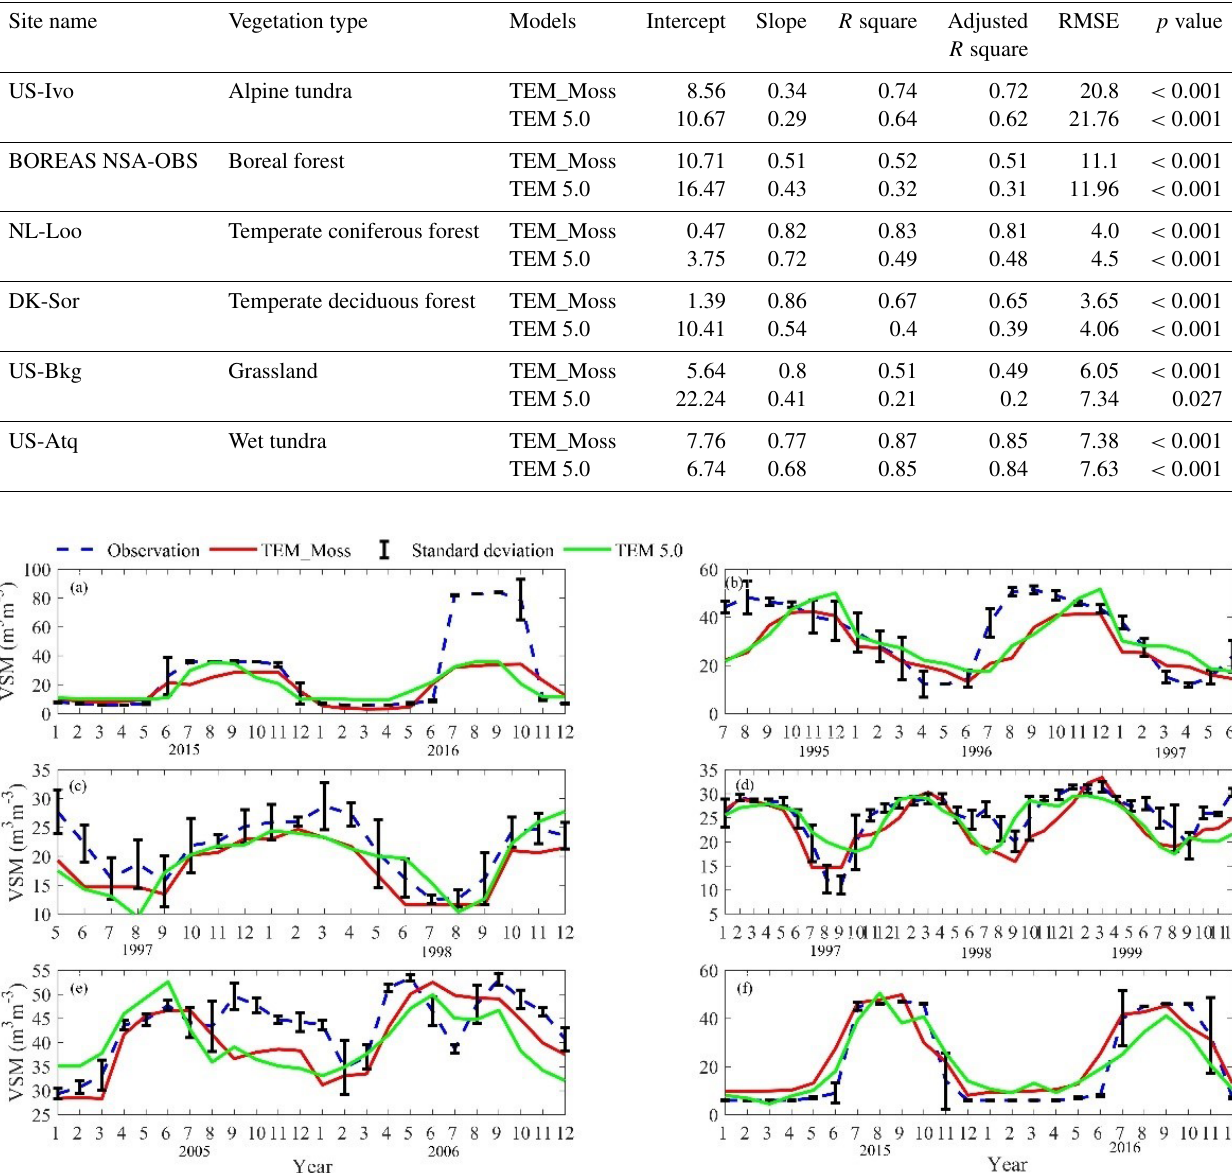
Table 7. Model validation statistics for TEM_Moss and TEM 5.0 at six sites with volumetric soil moisture data.